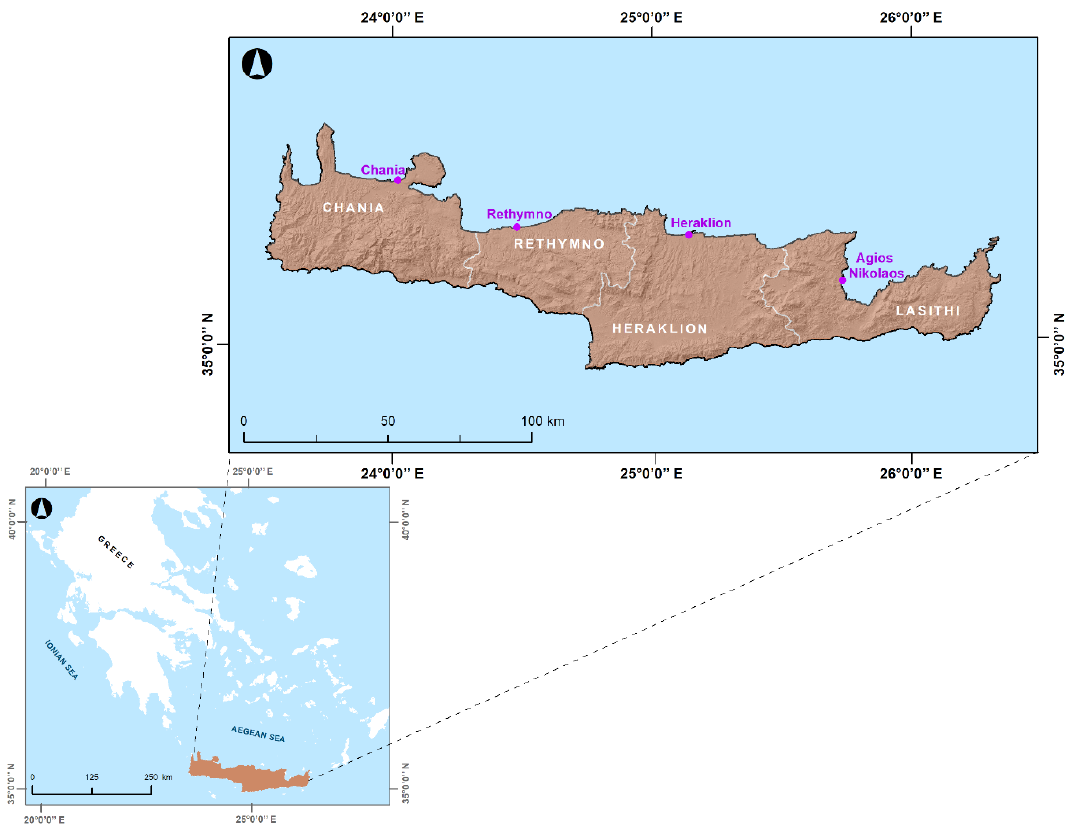
Figure 1. Location map and study area map presenting the prefectures of Crete Island and their capitals.